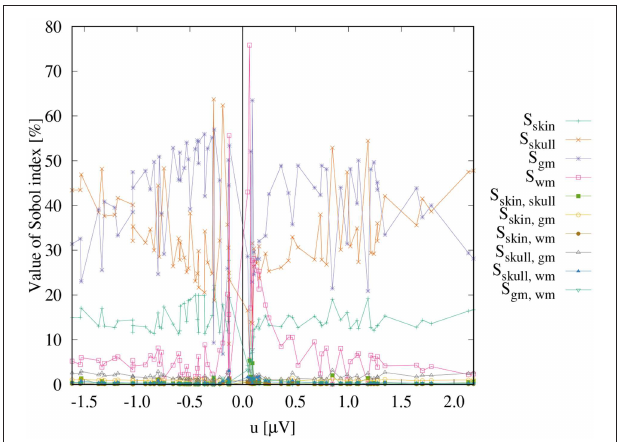
FIGURE 3 | Sobol indices as a function of the electrode voltages.